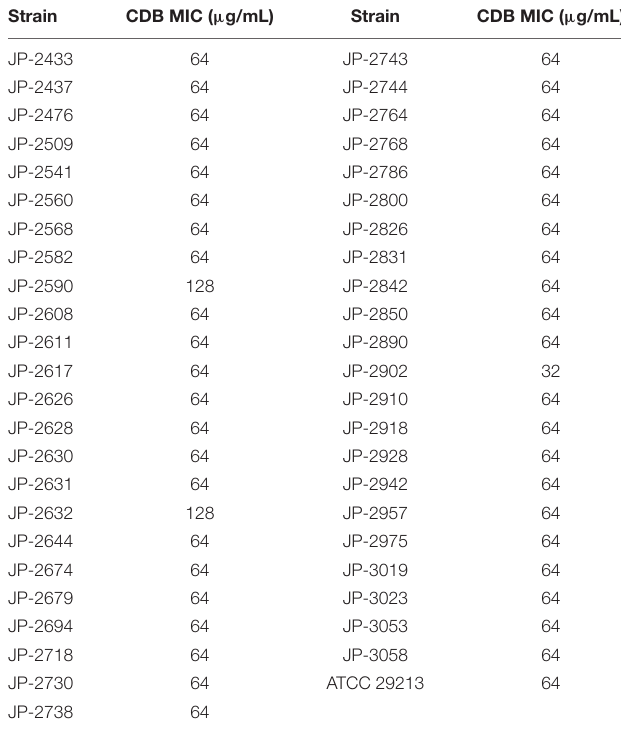
TABLE 2 | Antibiotic susceptibility of CDB against 46 clinical S. aureus isolates and S. aureus ATCC